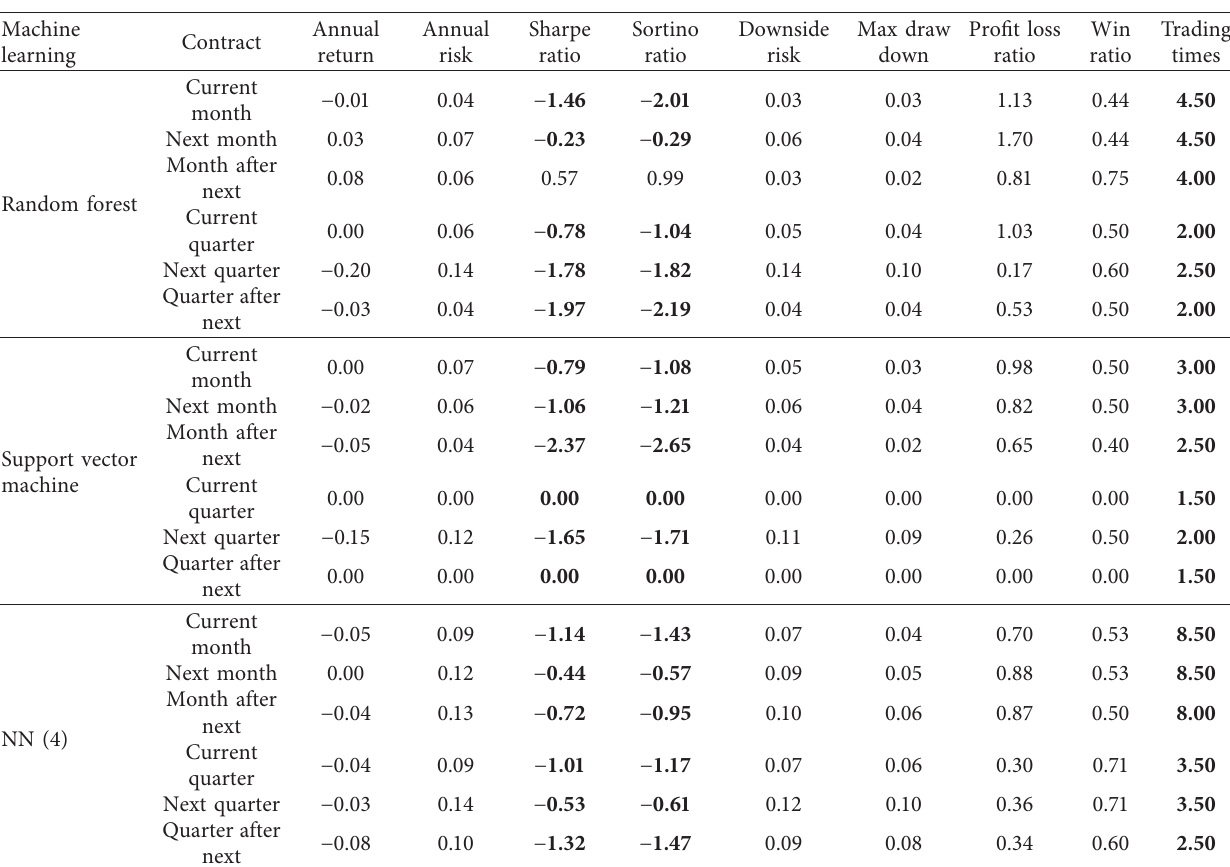
Table 18: Option strategy of predicting the rise and fall of volatility by threshold (use 30 features M4, threshold � 0.7). Machine